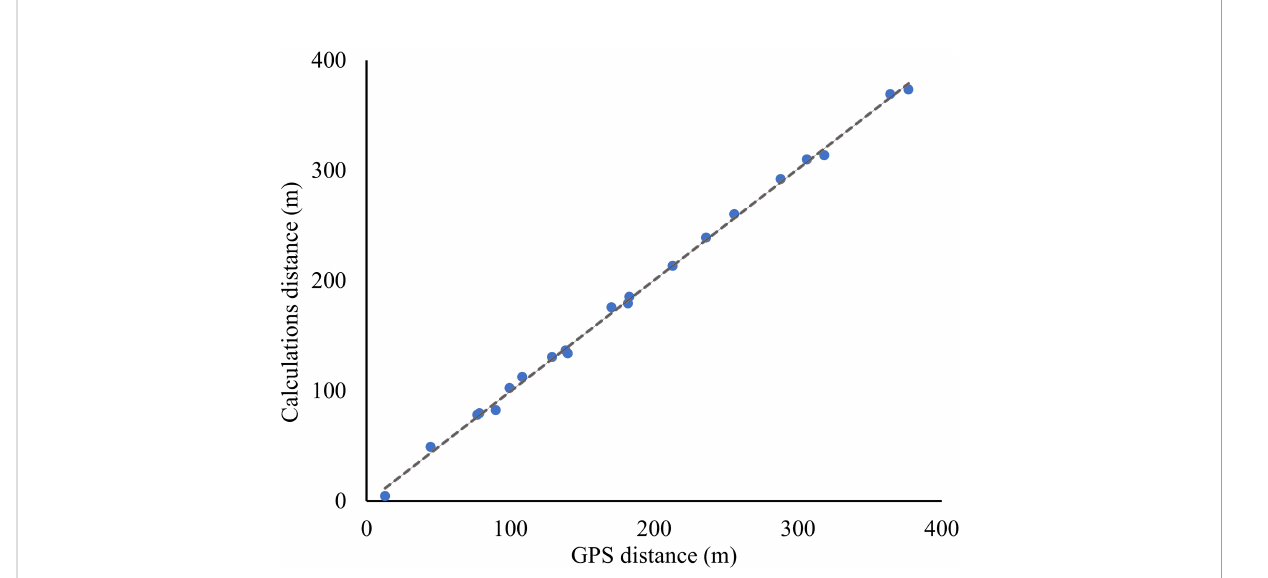
FIGURE 5 The distances between georeferencing points (m) as determined by inputting GPS locations into ArcMap (x) and by calculating using equations described in this paper